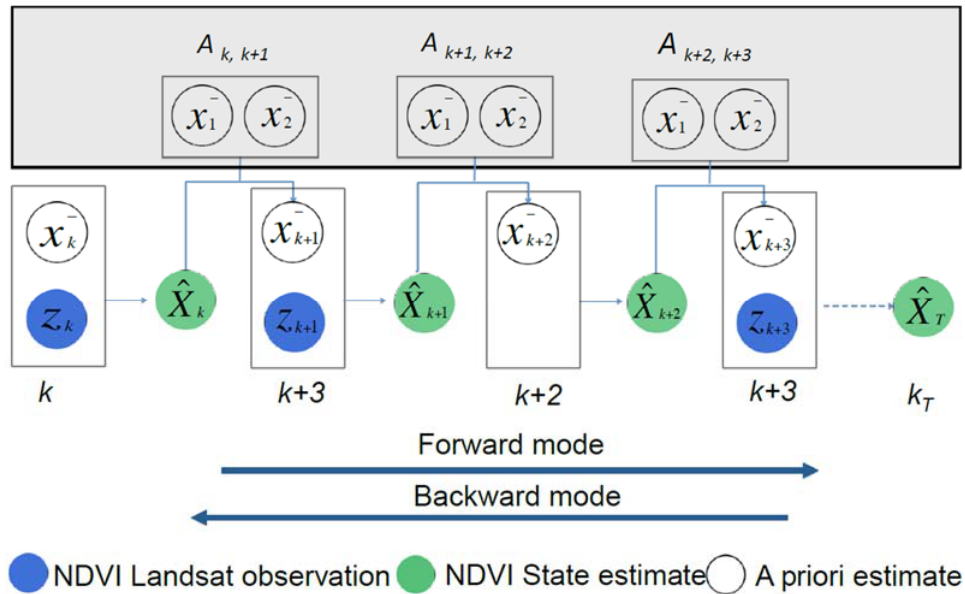
Figure 2. Flow chart of the Kalman filter approach. At each time step, the transition model, A , projects the estimate from a previous state (time update). The time update combines the estimates of Submodels 1 and 2, (cid:1850) (cid:3038)(cid:2869)(cid:2879) and (cid:1850) (cid:3038)(cid:2870)(cid:2879) , respectively, to produce a single a priori estimate, (cid:1850) (cid:3038)(cid:2879) . If available, a Landsat observation, Z k , provides a new estimate for the state (measurement update). The final estimate of the state, (cid:1850)(cid:3552) , is the weighted average of the (cid:3038) time update (transition model) and the measurement update (Landsat observation), with the weights inversely proportional to their respective uncertainties. If a new Landsat observation is not available, the estimate of the state at that time step is solely the result of the measurement update from previous time step. The model is alternatively run in forward and backward mode (filtering mode) and the corresponding estimates subsequently combined (smooth